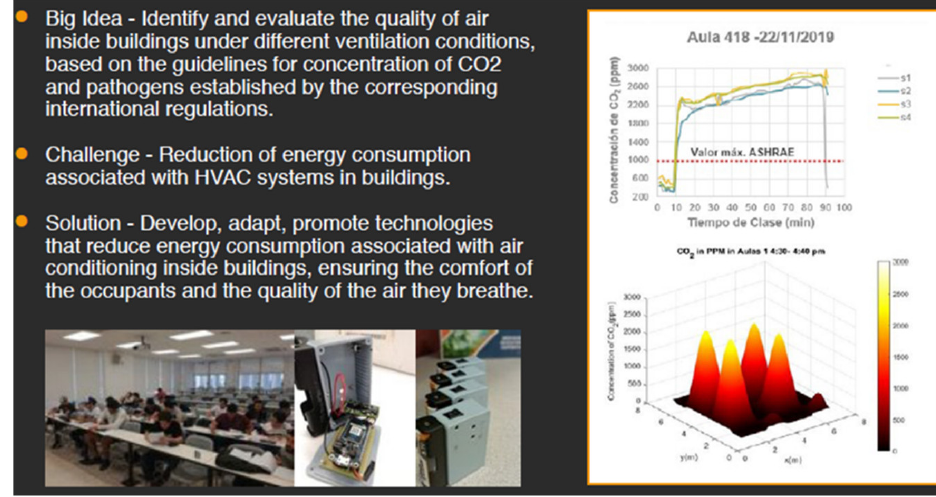
Figure 5. Use of low-cost sensors to monitor CO 2 concentration in classrooms.